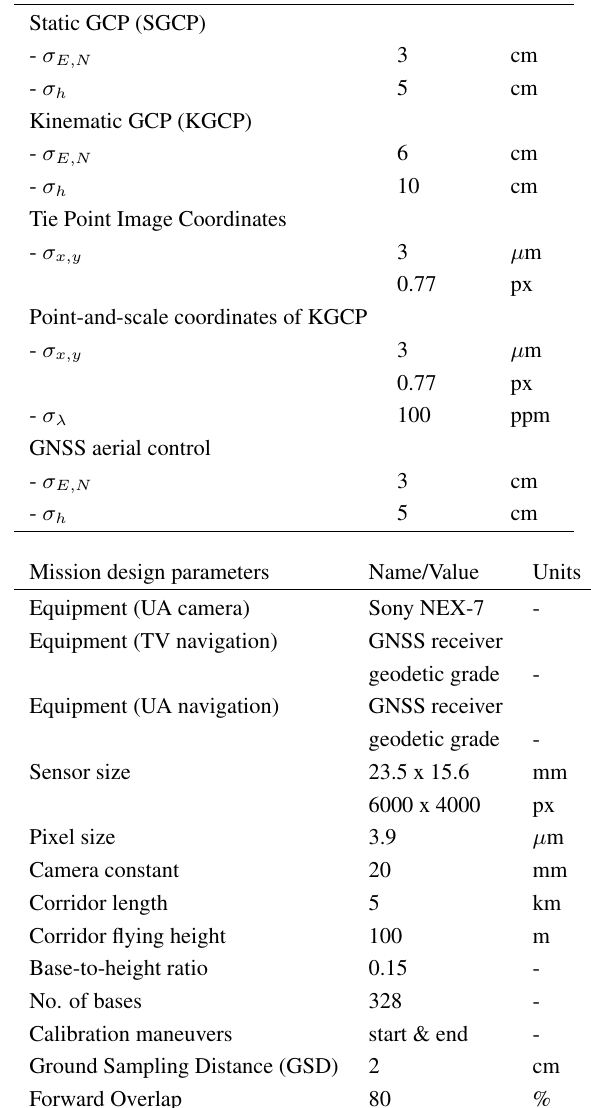
Table 2: Precision of observables and mission design